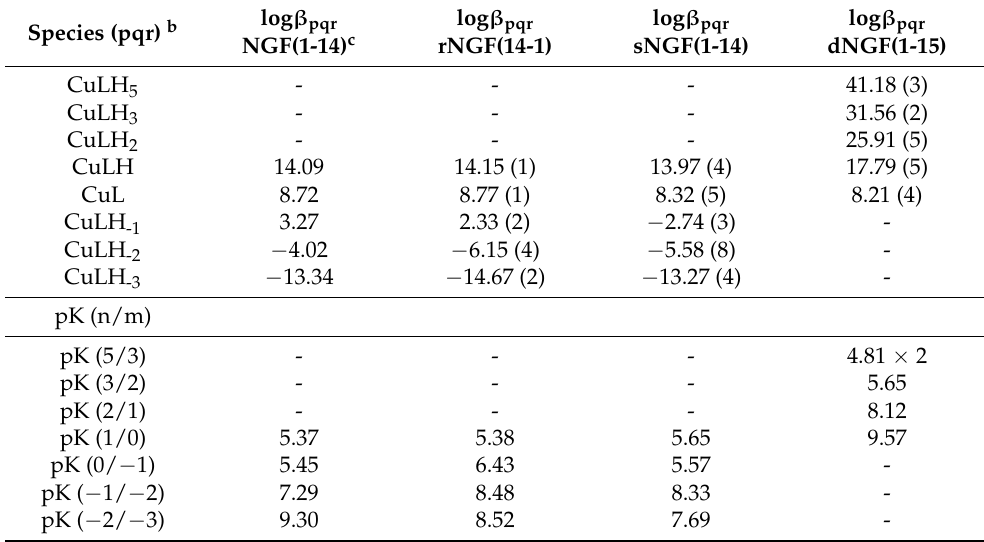
Table 2. Stability constants (log β pqr) and pK values of copper(II) complexes a .